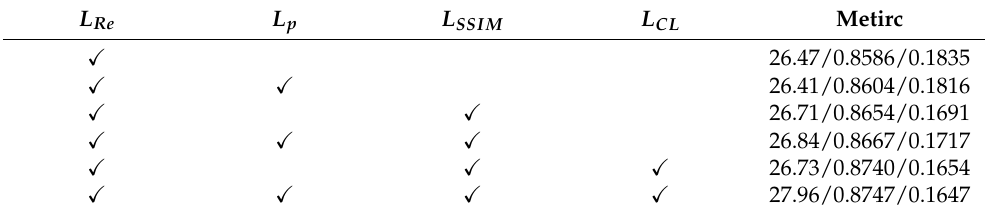
Table 4. Metric values (PSNR/SSIM/LPIPS) of the proposed PHMNet trained by different loss terms with dataset Rain200H